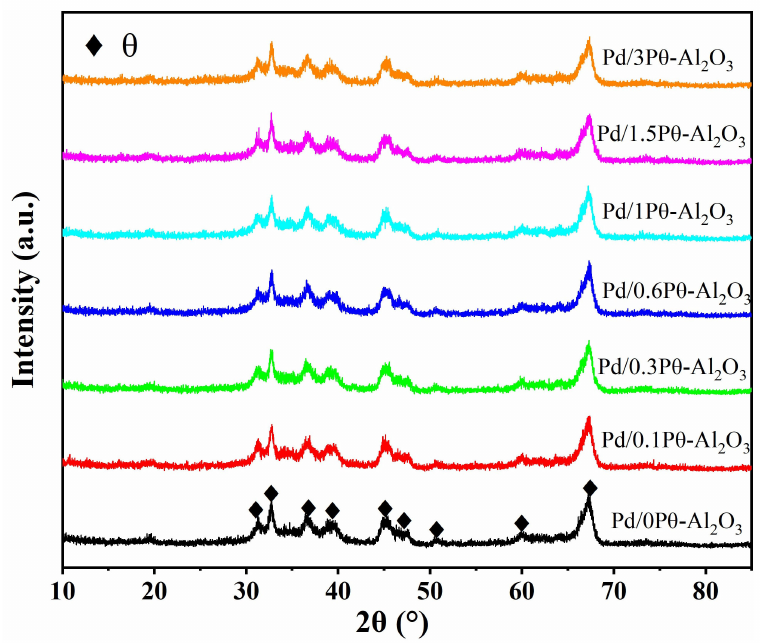
Figure 6. XRD patterns of Pd/xP θ -Al 2 O 3